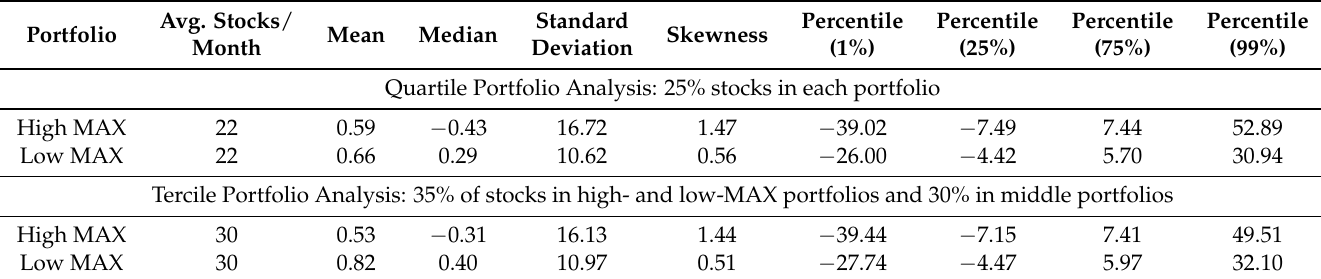
Table 1. The table reports descriptive statistics of high- and low-MAX portfolio stocks. The data are obtained from the TITLON database from January 1996 until December 2016. Portfolios are formed and re-balanced each month on the first trading day based on the maximum daily return in the past one month. All figures are percentages except skewness and avg.